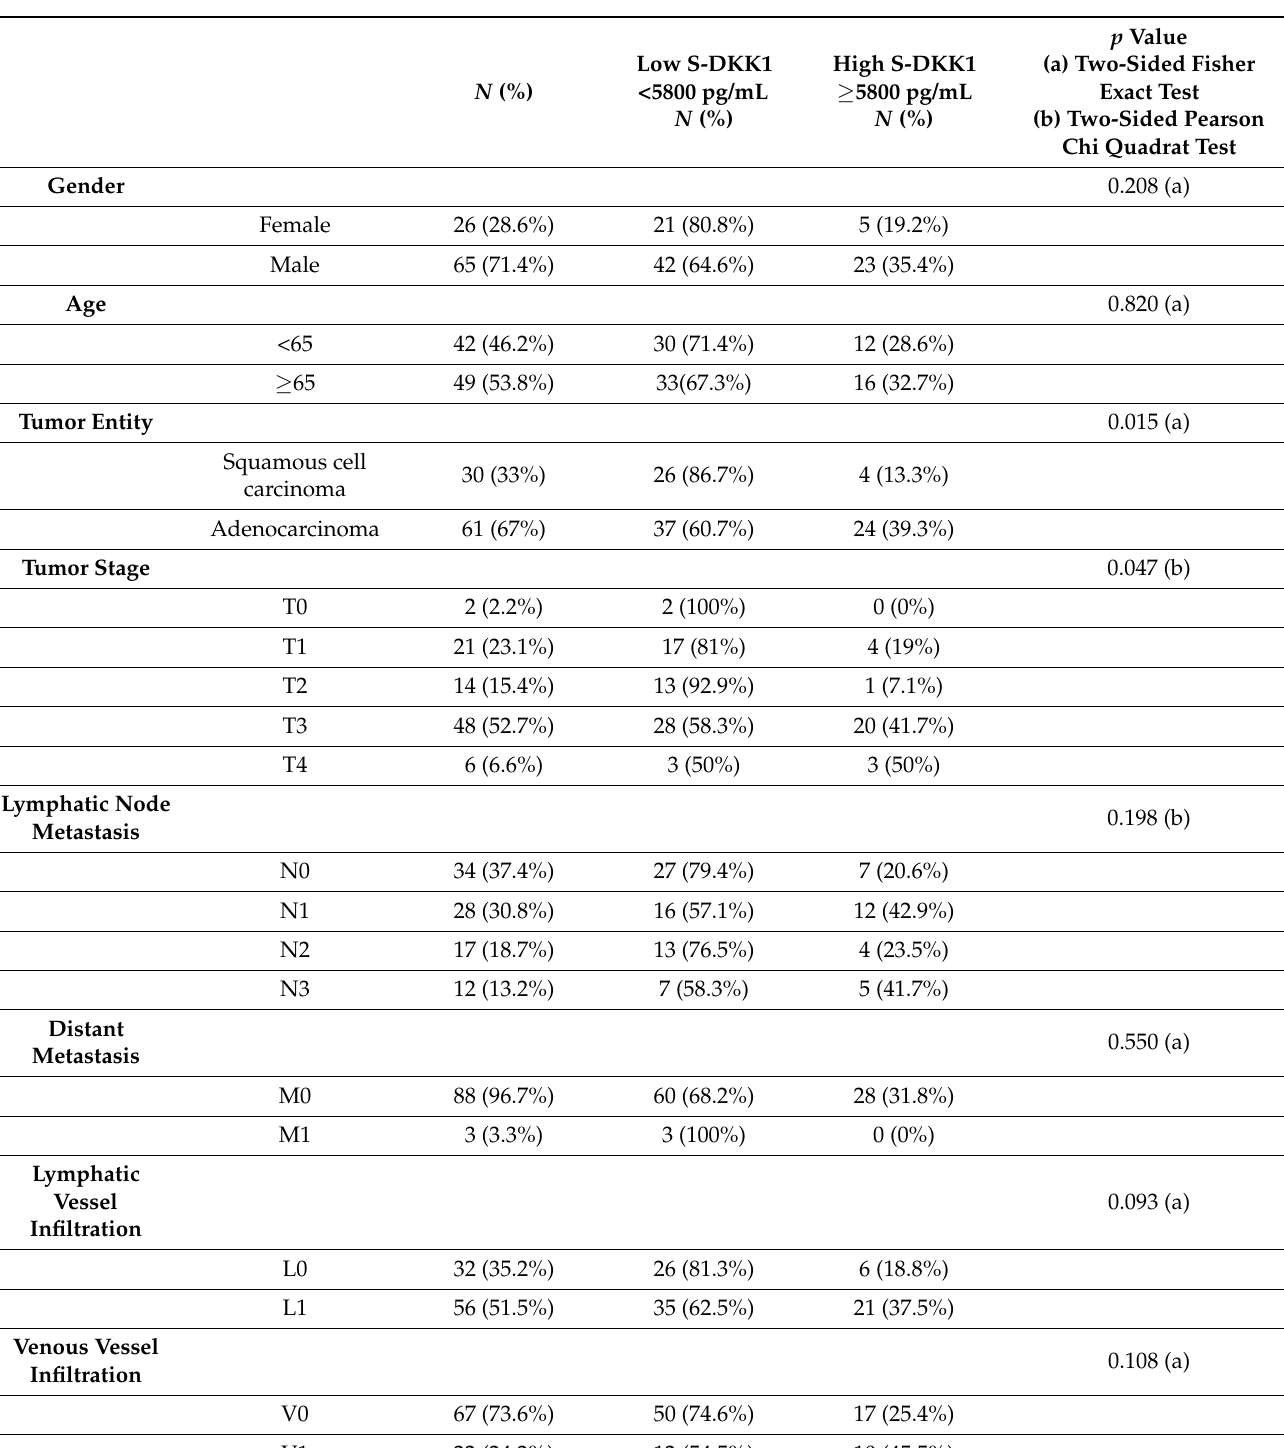
Table 1. Association of S-DKK1 with clinicopathological parameters in esophageal cancer.